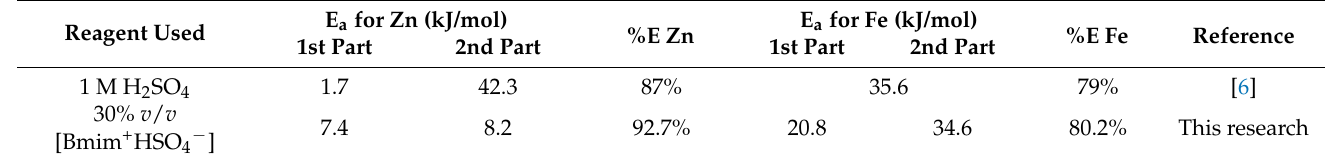
Table 2. The values for activation energy and extraction efficiency (%E) for Zn and